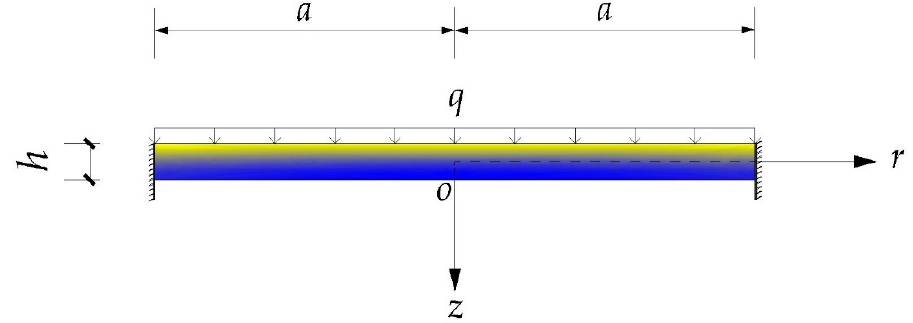
Figure 1. Scheme of a functionally-graded piezoelectric material (FGPM) thin circular plate under uniformly-distributed loads.